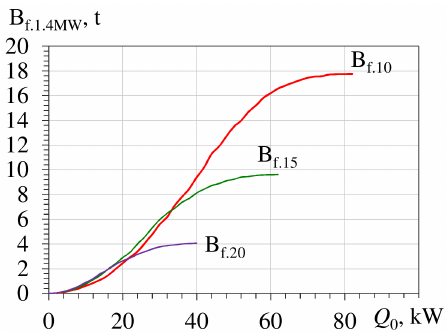
Figure 13. Annual fuel-saving Σ B B f versus design cooling capacities Q 0 of chillers for engine intake air temperatures at 15 and 20 ◦ C in ACh and 10 ◦ C in AECh (Mykolayiv region, south of Ukraine,